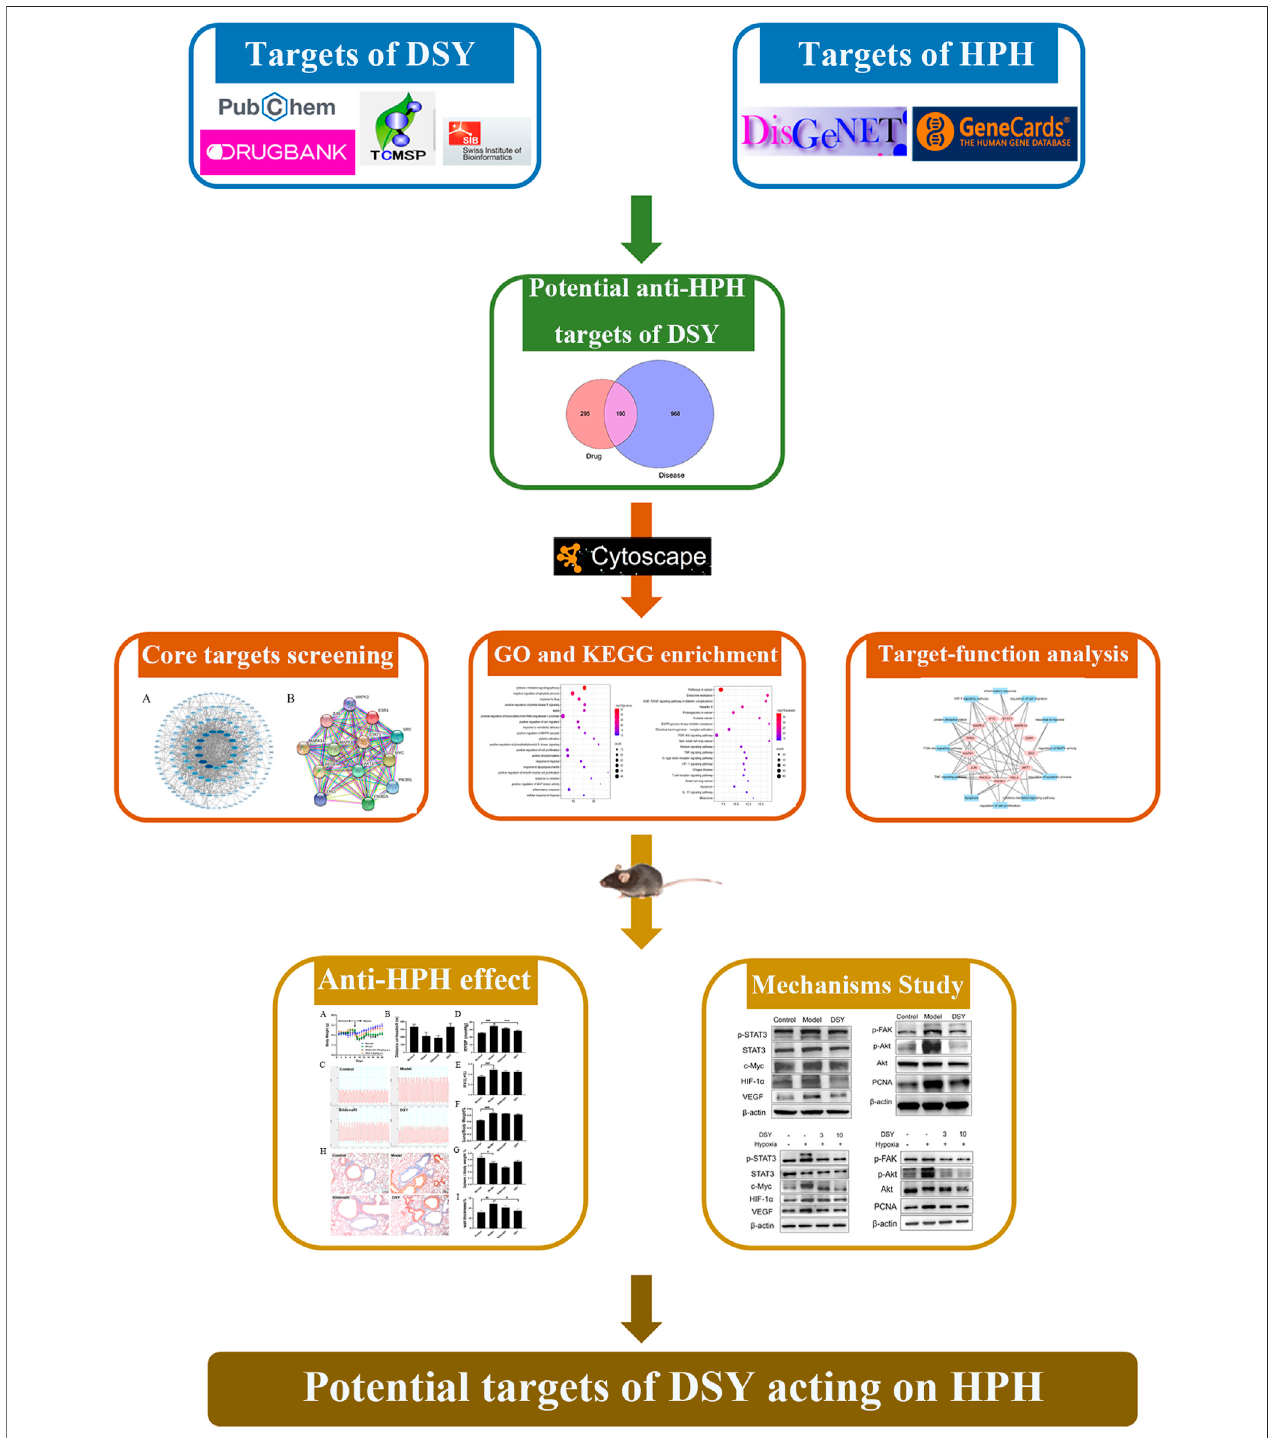
FIGURE 1 | Work fl ow of the present study.